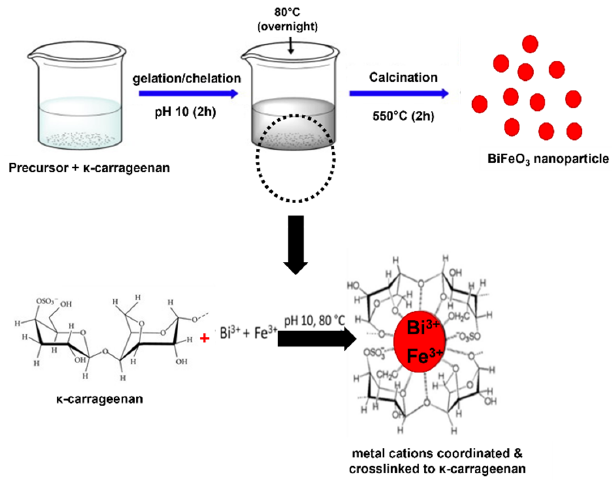
Figure 1. Schematic of kappa-carrageenan as a nanoreactor site for growth directing and stabilizing the metal oxide.